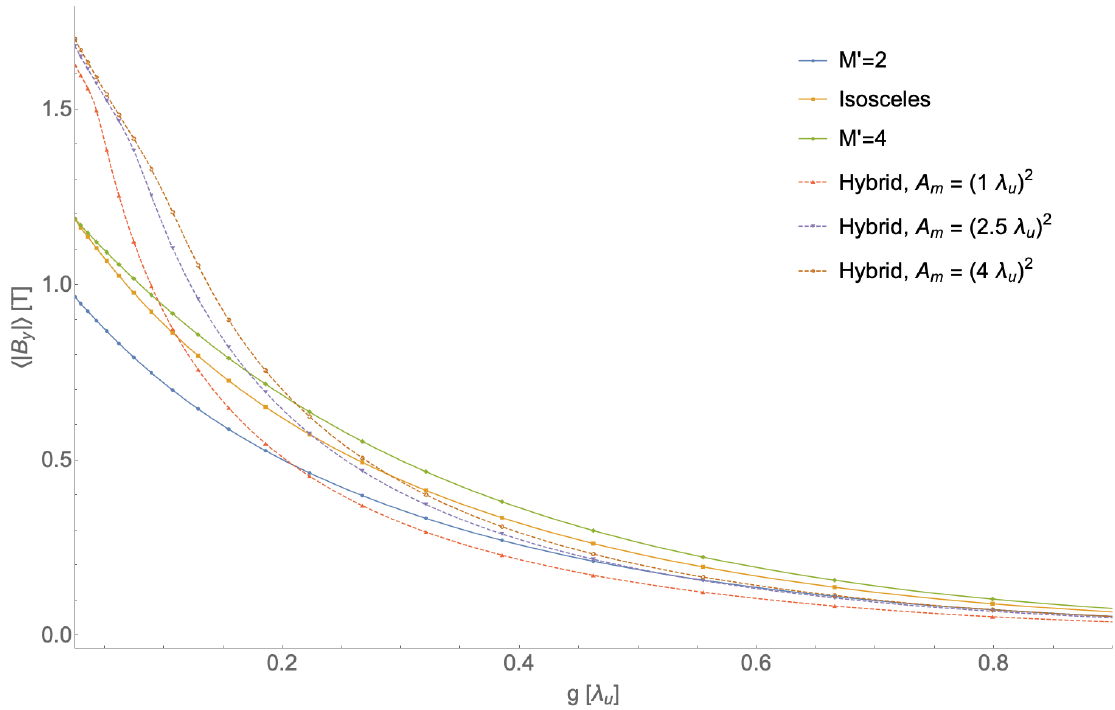
Figure 2. Mean, absolute fields, (cid:104)| B y |(cid:105) , for different Halbach geometries as a function of gap size, normalized to λ u , based on Radia